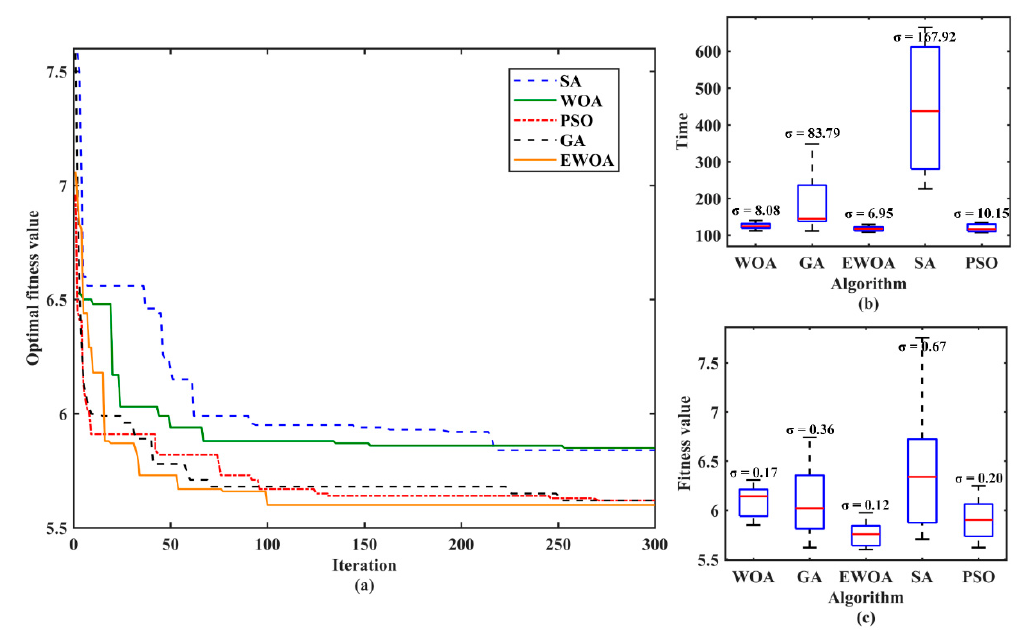
Figure 16. Optimization algorithm result comparison. ( a ) Curves of optimal fitness value; ( b ) Box diagram of calculation time; ( c ) Box diagram of optimal fitness.